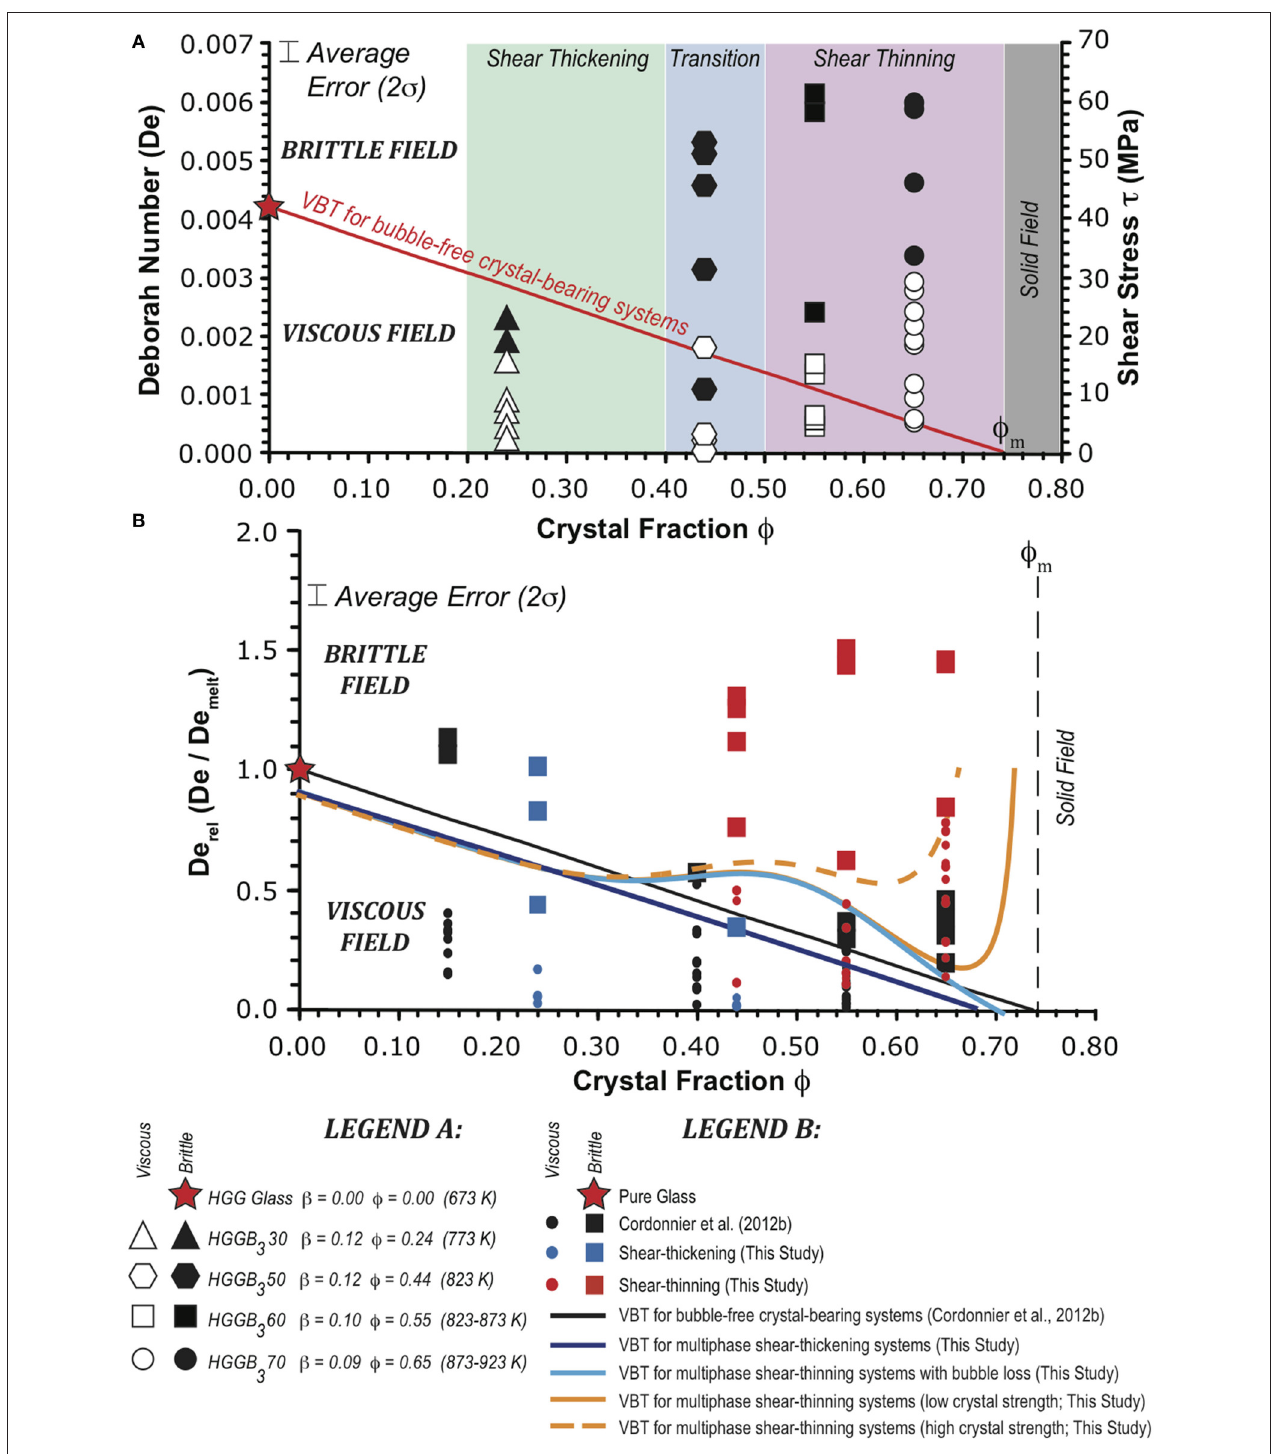
FIGURE 3 | (A) Deborah number (left) and shear stress ( τ , right) vs. crystal fraction ( φ ; and corresponding bubble fraction, β ) for representative experiments showing: shear-thickening ( φ < 0.44) and shear-thinning rheology ( φ > 0.44). The VBT for bubble-free crystal-bearing systems is calculated with Equation (3). (B) Relative Deborah number ( De rel , ratio of Deborah numbers of a multiphase magma [ De bulk ] and a pure melt [ De melt ], respectively) vs. φ for experiments from this study and Cordonnier et al. (2012b). Experiments with reverse strain-rate stepping (from high to low) are not reported here (see Table 2 ). All experimental data for the viscous and brittle regimes reported here are based on the peak shear stress at a specified applied constant strain-rate prior to brittle failure and normalized with De melt from this study. This diagram shows all the possible VBTs linking low crystallinity (where outgassing dominates) and high crystallinity (where shear banding is dominant), estimated using Equation (5) from this study. φ m denotes the maximum packing fraction. See the text for further details.